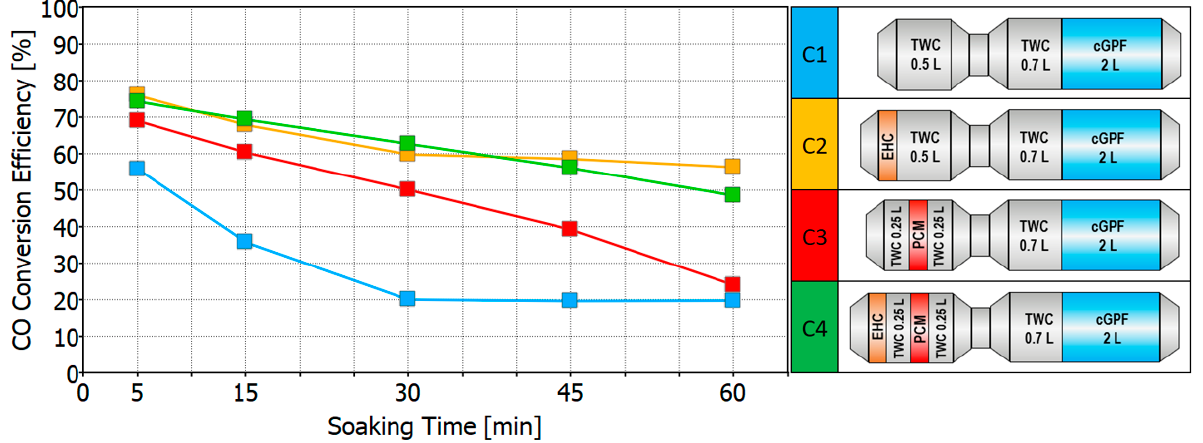
Figure 23. Results for performance benchmarking of different EAT line architectures.